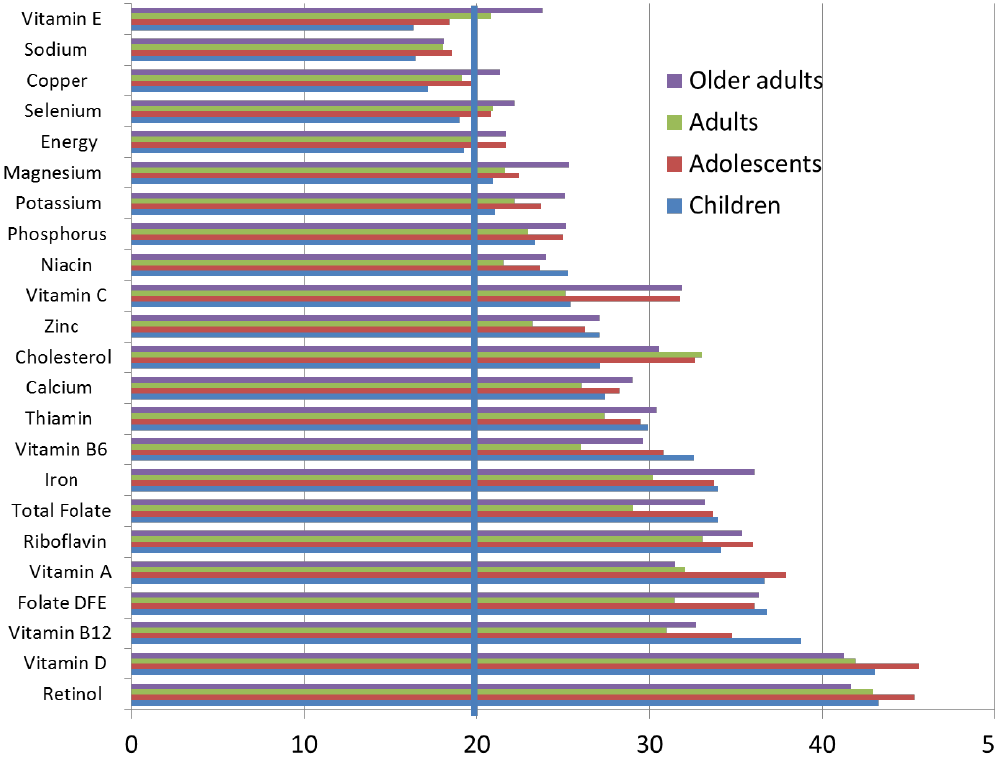
Figure 2. Percent contribution of breakfast to micronutrient intakes relative to energy intakes among breakfast consumers. The 20% cut point is indicated by the vertical line.